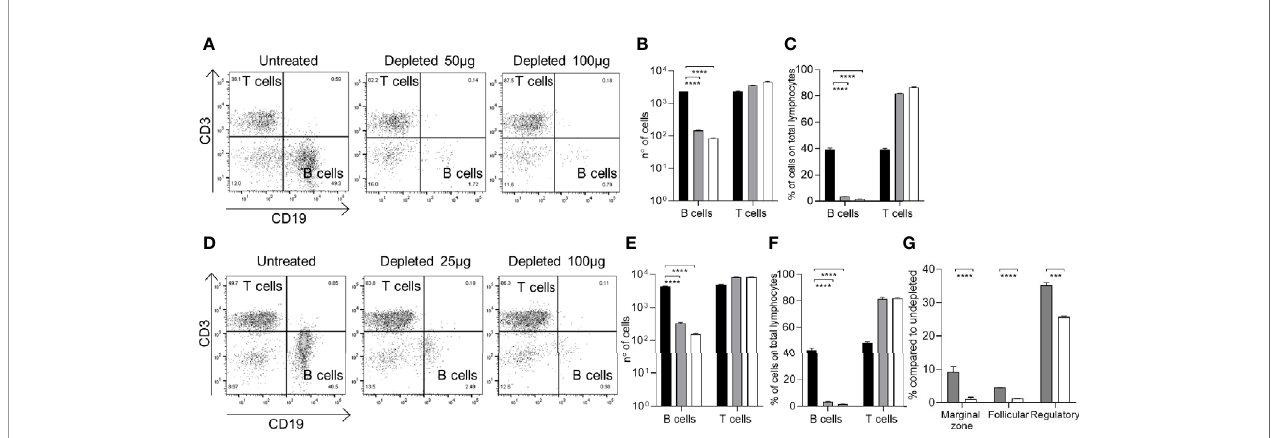
FIGURE 1 | Effects of IP or IV administration of aCD20 on splenocyte B cell populations in C57Bl/6 mice. Splenocyte B cell (anti-CD19 antibody) and T cell (anti-CD3 antibody) populations were quanti fi ed using fl ow cytometry 7 days after the administration of the aCD20 antibody (SA271G2 BioLegend). (A – C) IV administration of either 50µg or 100µg aCD20, showing representative fl ow cytometry plots (A), total cell numbers (B) , and cell population proportions (C) . (D, E) IP administration of either 25 µg or 100 µg aCD20, showing representative fl ow cytometry plots (D) , total cell numbers (E), and cell population proportions (F) . (G) Effects of B cell depletion on B cell subsets for IP treated mice; marginal zone (CD5-CD21+CD23-IgM+), follicular (CD5-CD23+IgM-) and regulatory (CD5+CD21+IgM+) B cell populations are shown. For all histograms columns represent means, error bars SDs: black bars, undepleted; gray bars, low-dose depleted; white, high-dose depleted (n=3). Mann Whitney U test was used for statistical analysis (***P < 0.001, ****P <